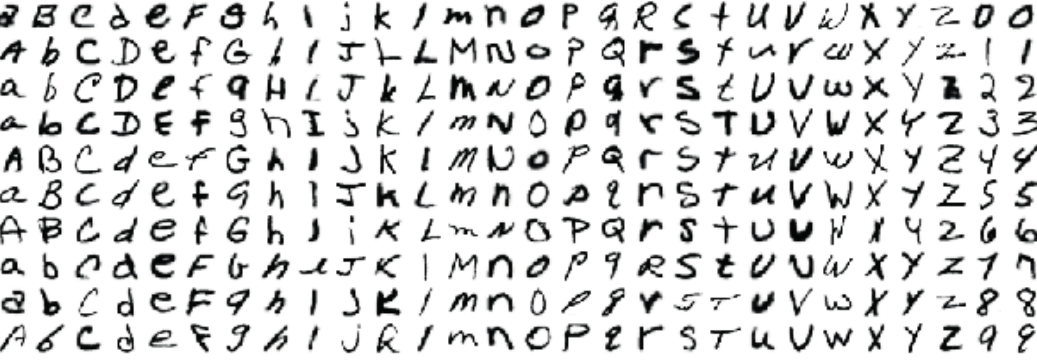
Figure 2. Samples of all letters and digits in the EMNIST